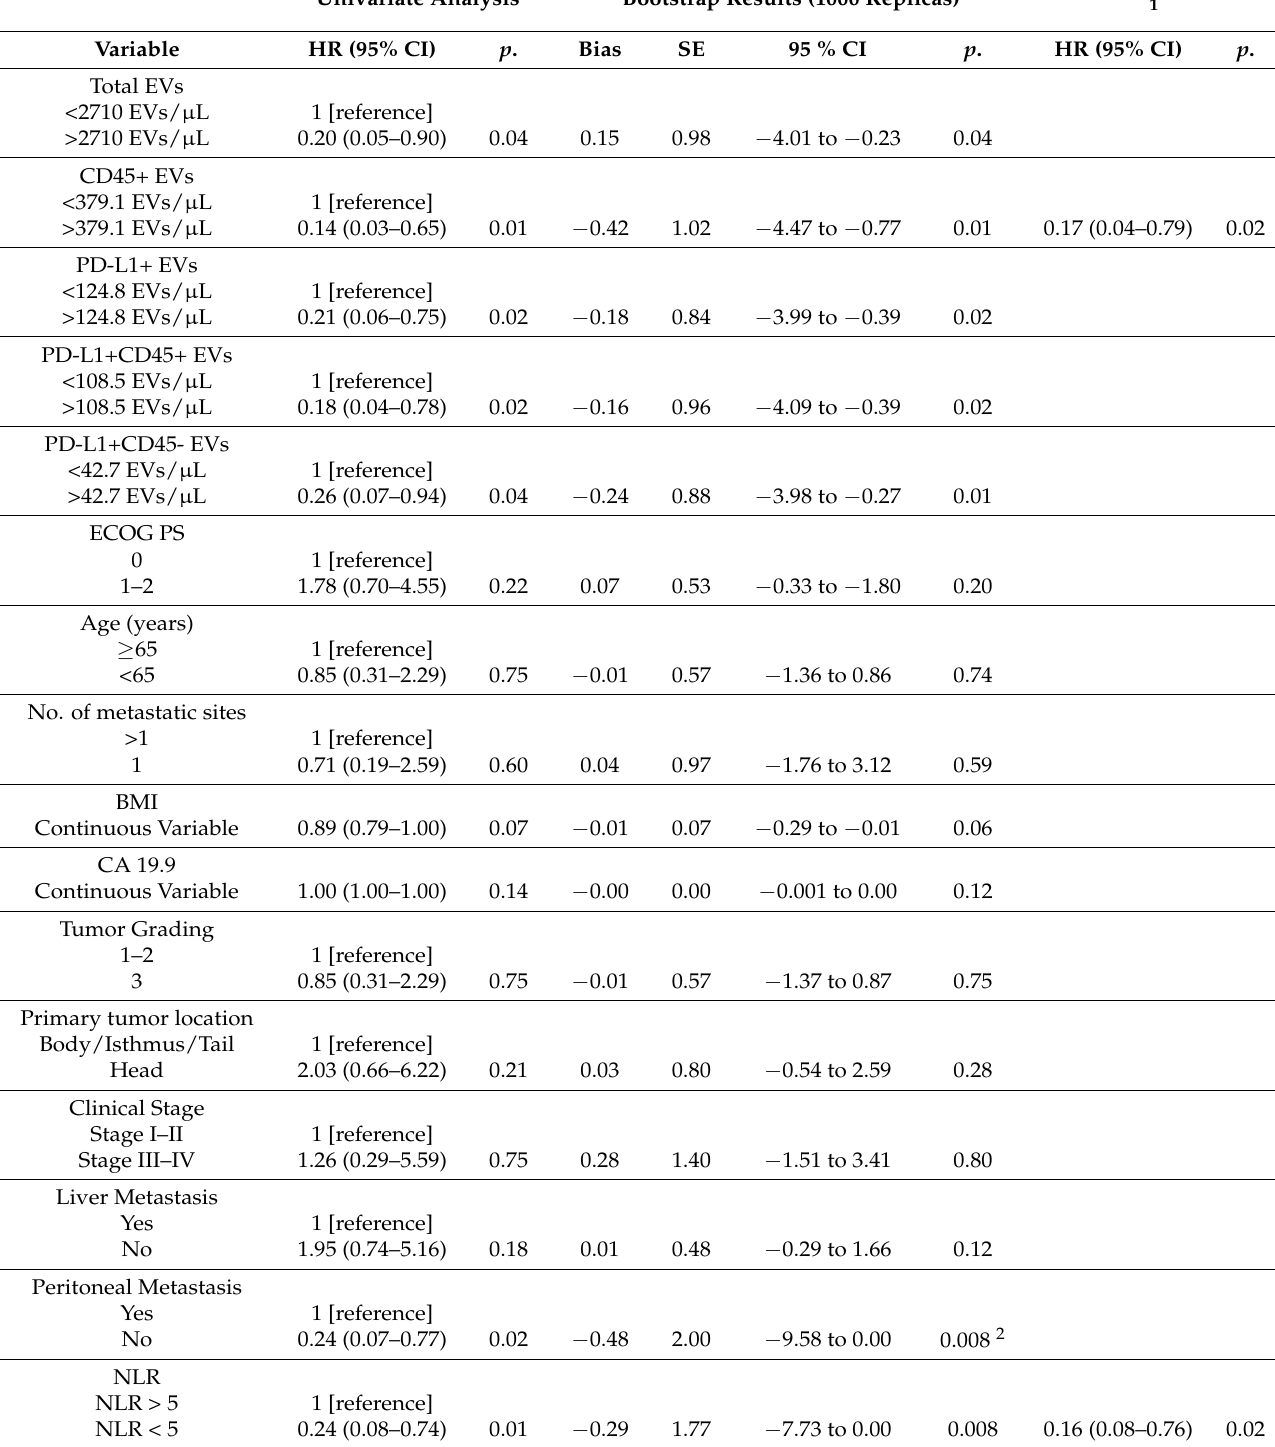
Table 4. Univariate and multivariate Cox proportional hazards model predicting OS in the cohort of patients with borderline resectable, locally advanced, or metastatic PC ( n = 47). Univariate Analysis Bootstrap Results (1000 Replicas)